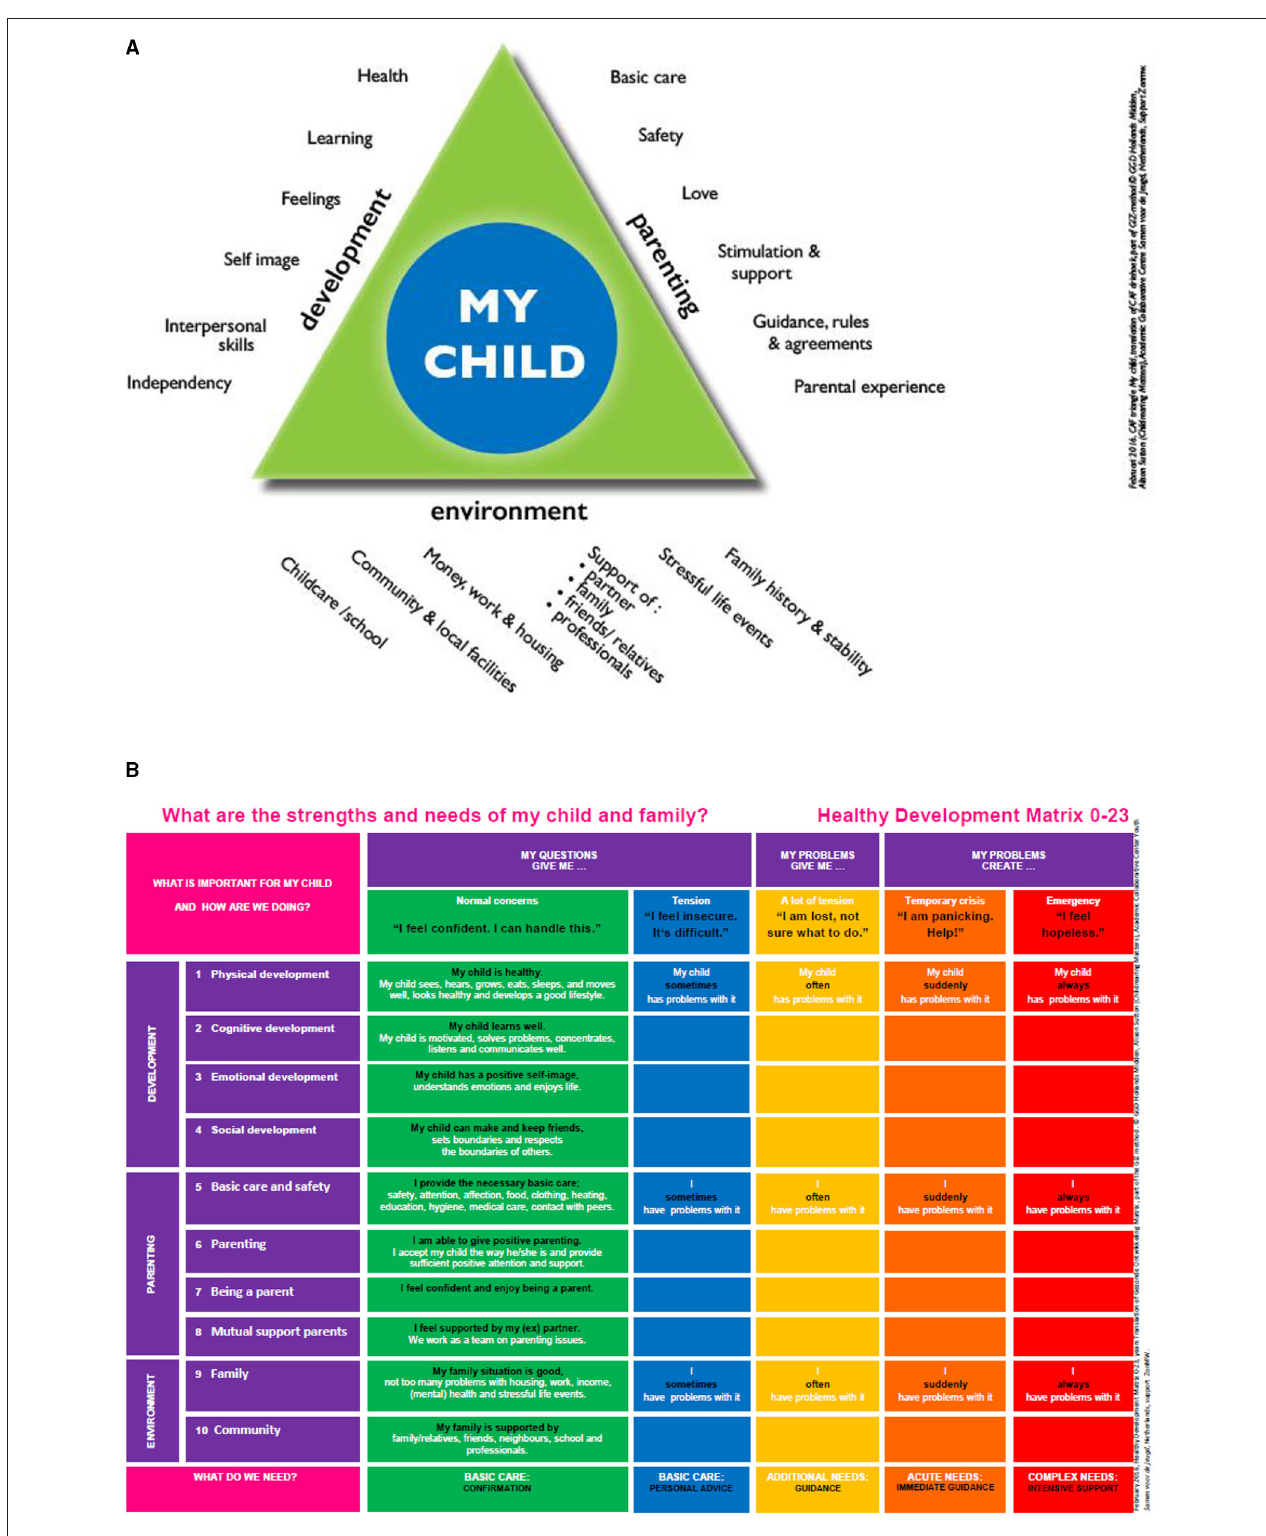
FIGURE 1 | (A) The common assessment framework-triangle. (B) The healthy development matrix.